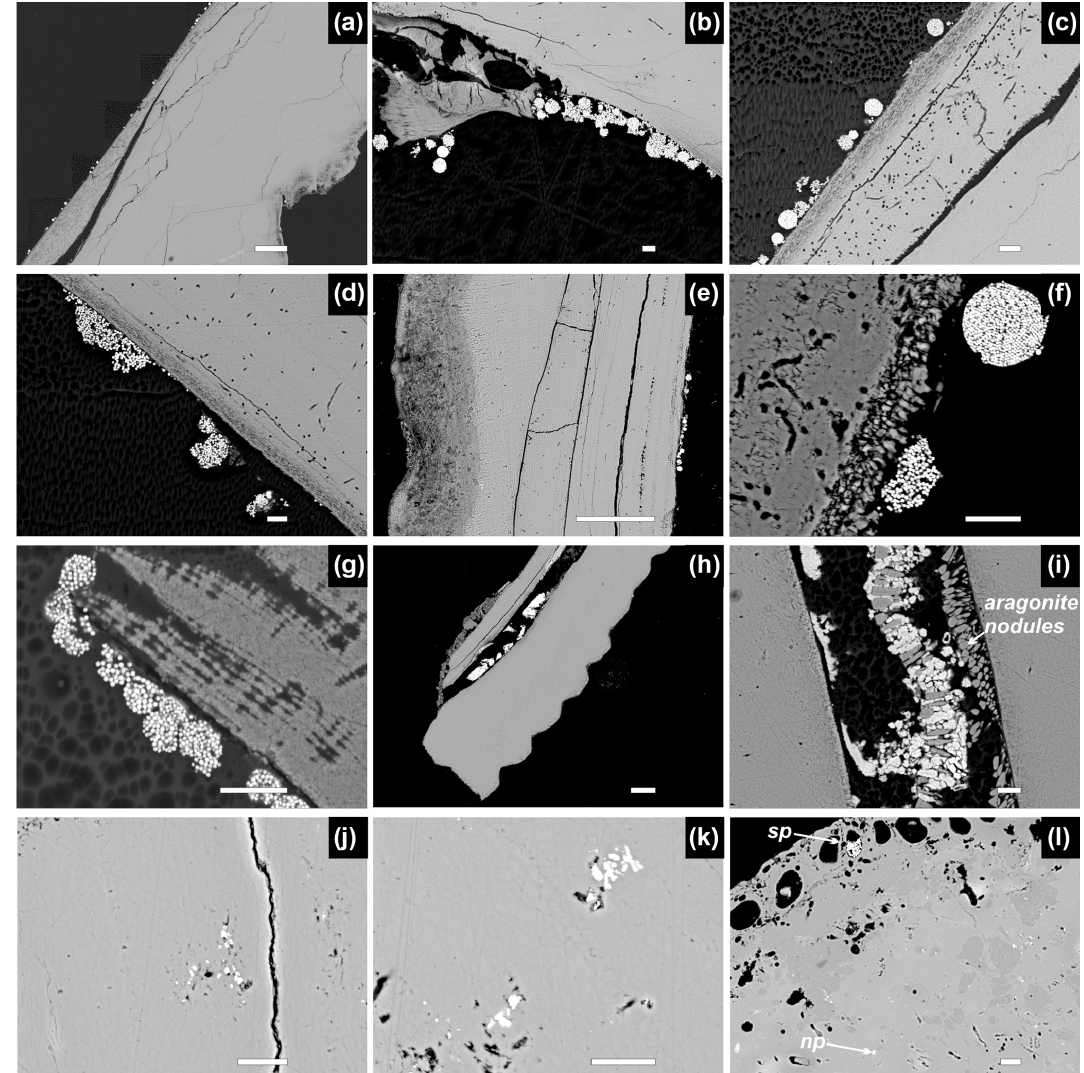
Figure 8. Backscattered electron images showing pyrite framboids on V. gibba valve interiors and in the main conchiolin layer in well- preserved valves and pyrite framboids and nanopyrite in microborings or microfractures in highly altered valves. (a–d) Pyrite framboids attached to the interior surface, Po 3 (M14)-40-45cm. (e–f) Pyrite framboids attached to the interior surface, Po 4 (M21)-90-95cm. (g– i) Pyrite framboids on the interior and framboids (located between aragonite nodules) rimmed by Fe oxides in the main conchiolin